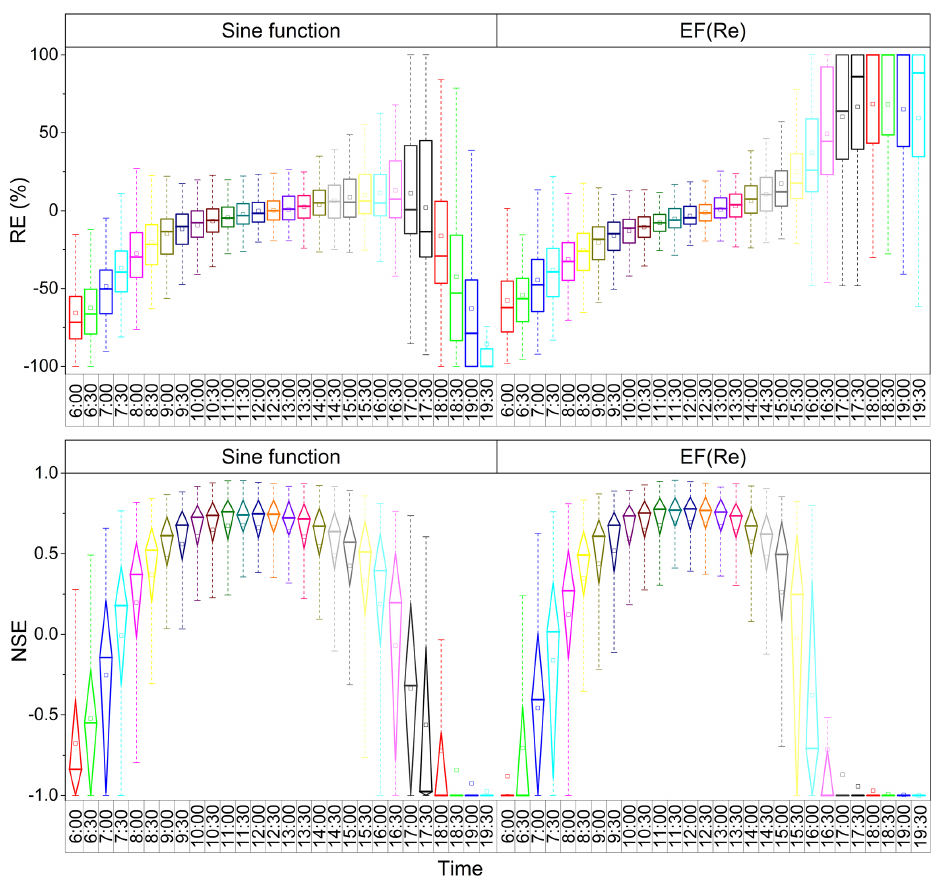
Figure 9. RE and NSE of simulated daily LE using the sine function and EF( R e ) methods at different times of the day.